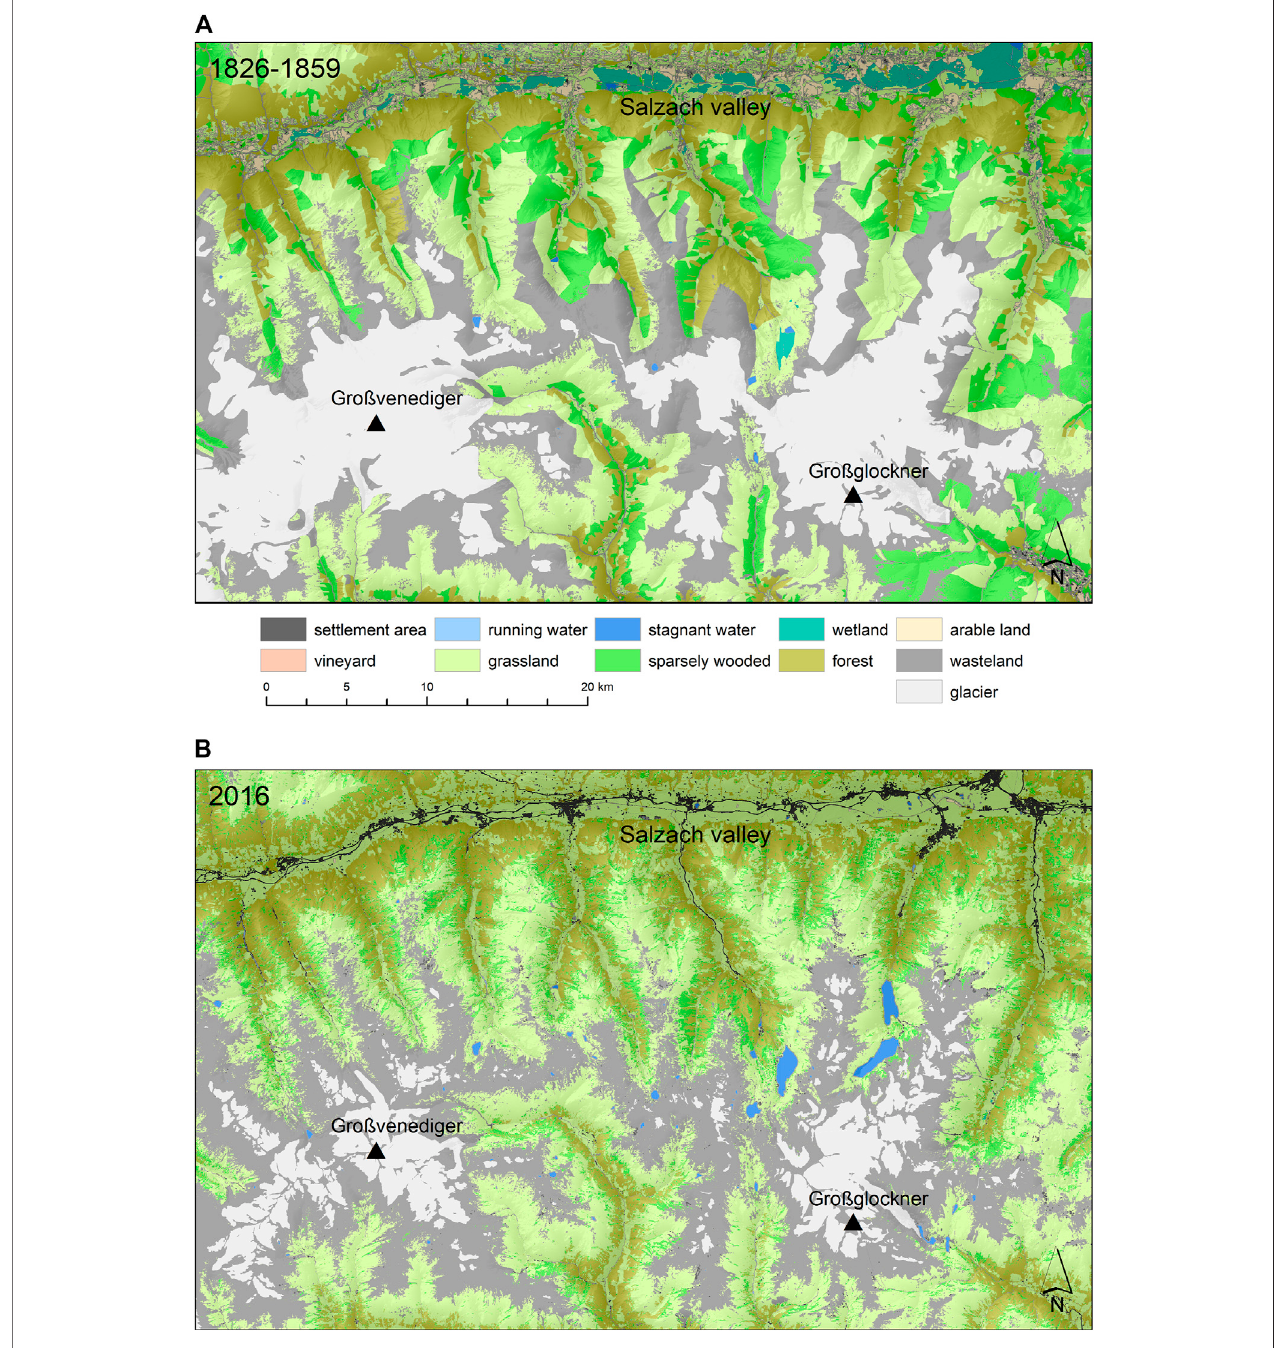
FIGURE 3 | (A) Land cover between 1826 and 1859 in the region of Austria ’ s highest peaks south of the Salzach valley; (B) land cover in 2016 (see location of the detail in Figure 1 ).